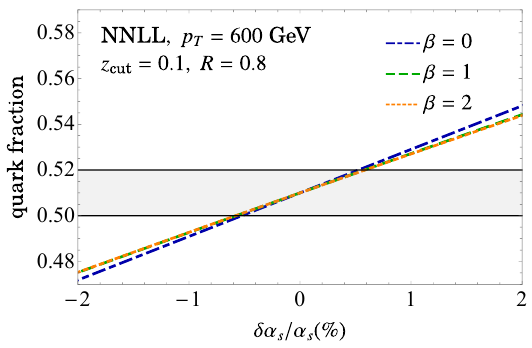
Figure 8 . Variation of the quark fraction that would give a similar change as a certain variation in α . We take the central values to be a 51% quark fraction and 49% gluon fractions, and the grey s lines represent a one percentage-point variation in the